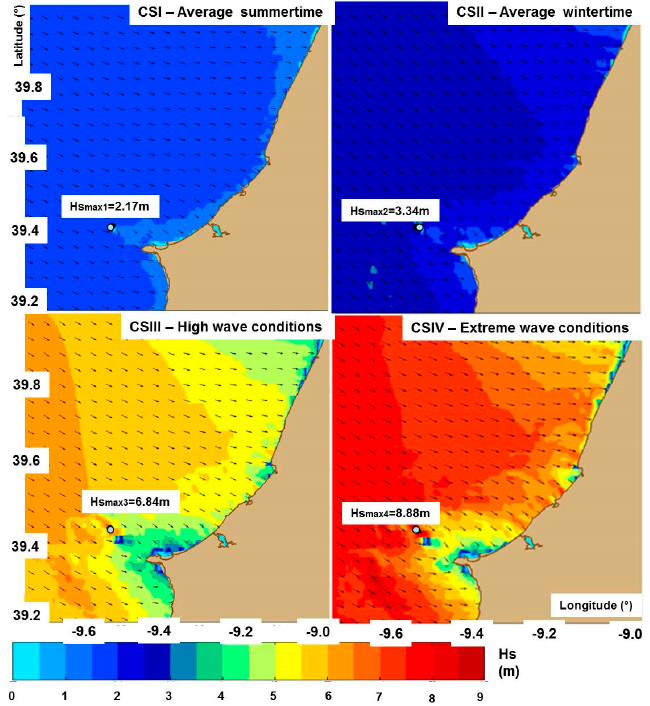
Figure 5. Wave propagation patterns in the target area corresponding to four representative case studies.